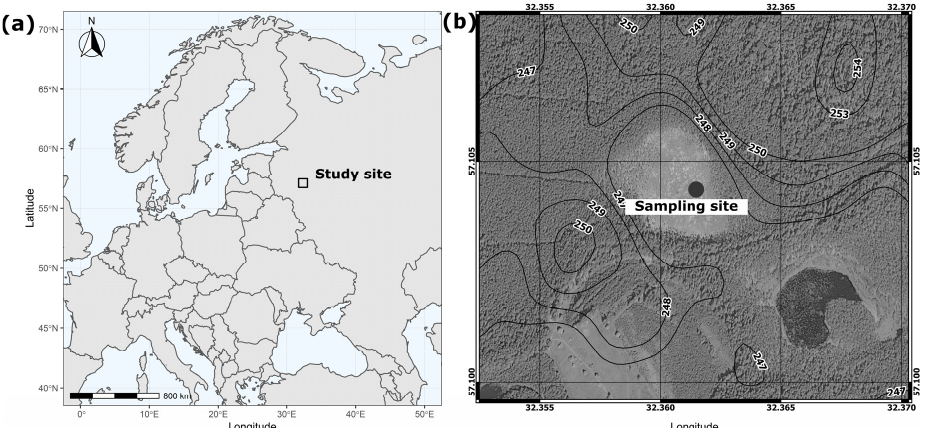
Figure 1. ( a ) The study area (source: https://www.naturalearthdata.com/, accessed on 12 May 2022) and ( b ) the study site (source: Yandex.Maps service). The elevation lines are created with a resolution of 1 m based on the SRTM 1 arc-second global (source: https://earthexplorer.usgs.gov, accessed on 12 May